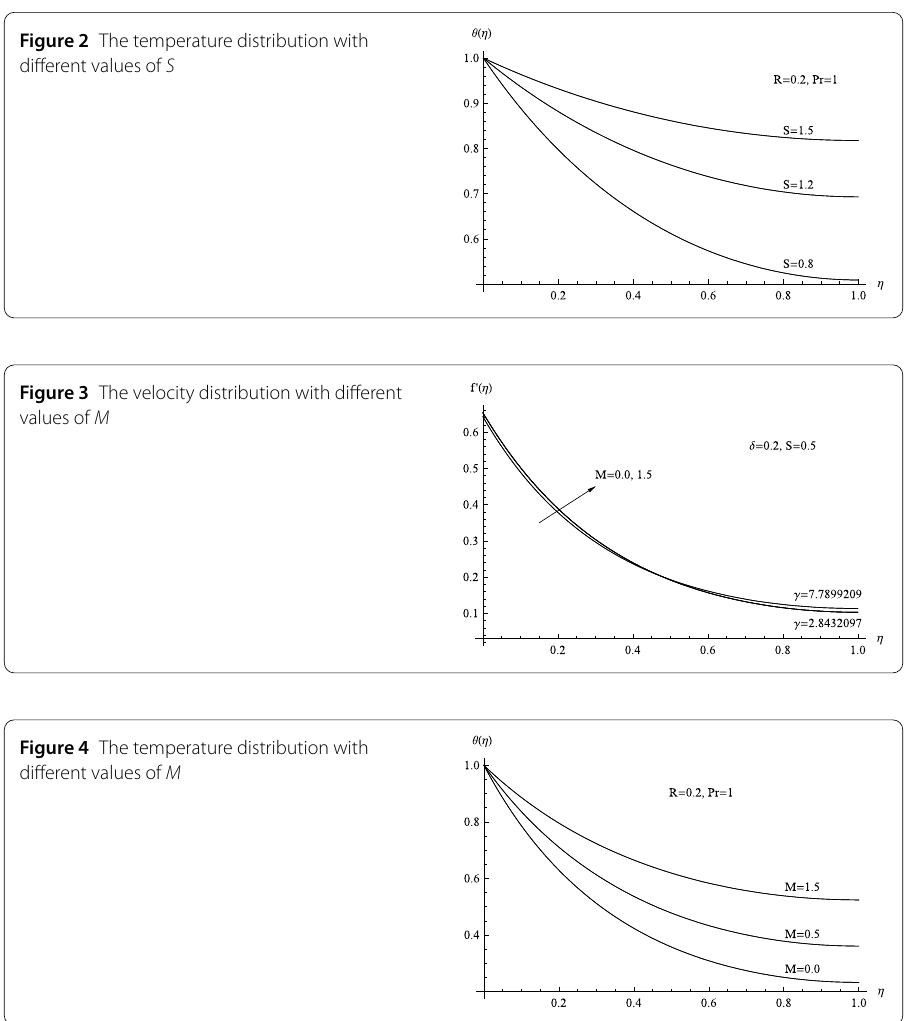
Figure 4 The temperature distribution with different values of